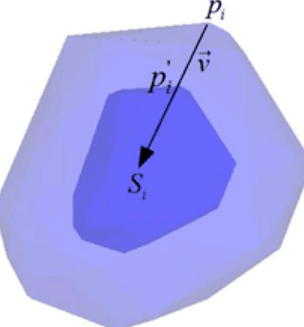
Figure 2. Schematic diagram of shrinkage for a single aggregate.